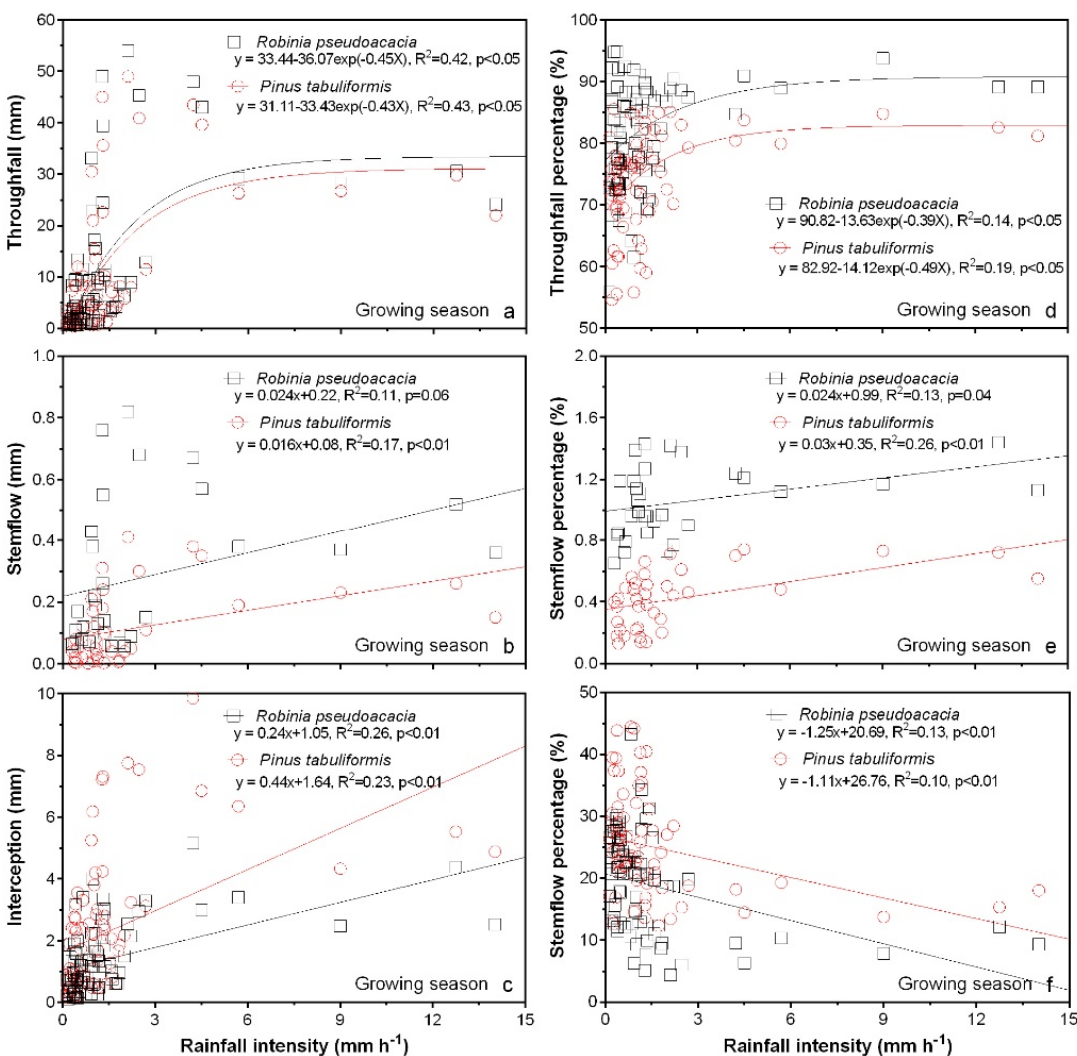
Figure 3. Relationships between individual rainfall intensity and rainfall partitioning components for R. pseudoacacia ( a – c ) and P. tabuliformis ( d – f ) rowing season in 2015 and 2016.